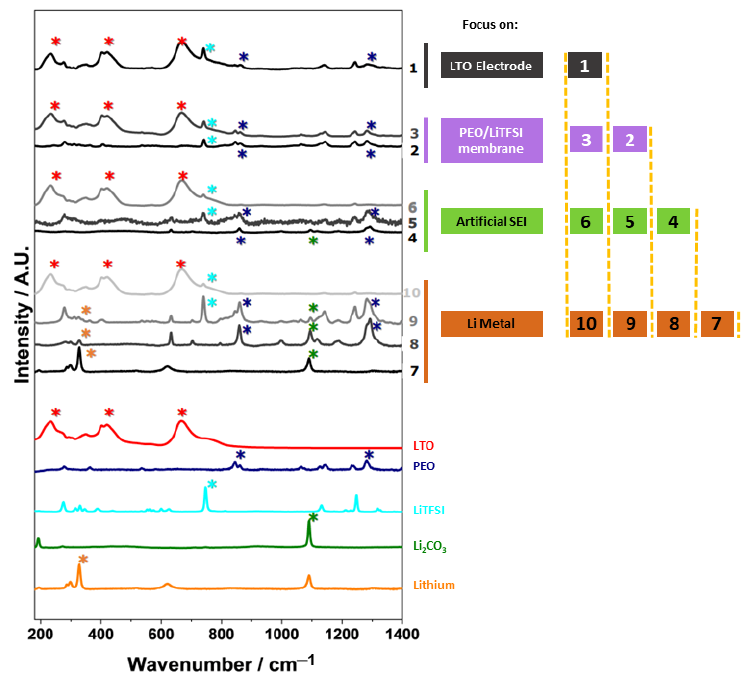
Figure 5. Raman spectra obtained from the step ‐ like system by micro ‐ SORS, with their positions desig ‐ nated numerically. For comparison, the obtained spectra of the layer constituents (as shown in Figure 4) are used as a reference to indicate the main peaks, which can be observed by *. Examination of the ob ‐ servable peaks in comparison to the layer depth at which they were measured demonstrates the degree to which the defocused micro ‐ SORS was able to obtain spectroscopic data.